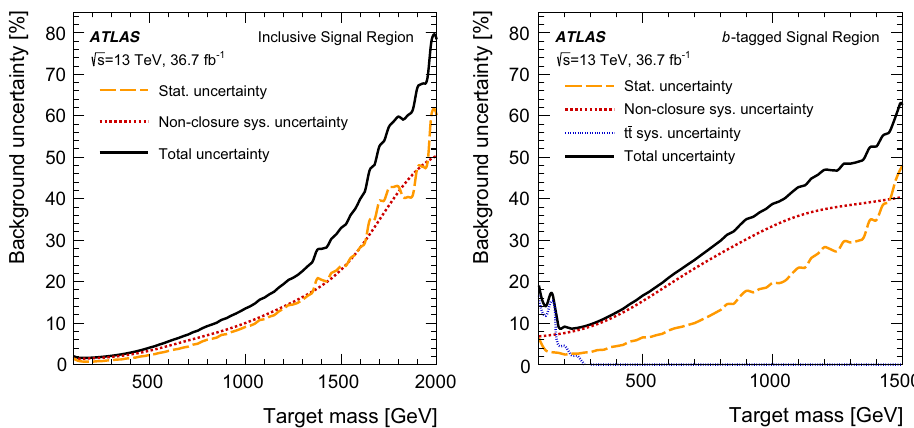
Fig. 7 The uncertainty in the data-driven background estimate in the inclusive (left) and b -tagged (right) signal regions, computed in the m avg mass windows defined for different target masses. The uncer- tainty arising from the non-closure in the validation region is shown with a red short-dashed line and compared with the statistical uncer-